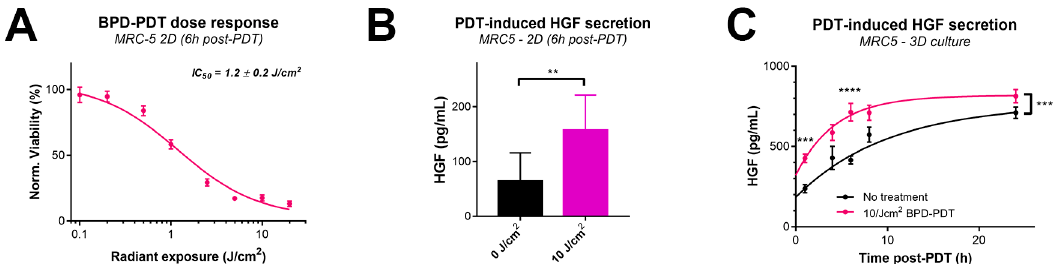
Figure 4. PDT elevates HGF secretion by MRC5 cells in 2D and 3D. ( A ) Efficacy of benzoporphyrin derivative (BPD)–PDT on MRC5 cells cultured in 2D. Depicted are mean ± SEM from N ≥ 12 obtained from four technical repeats. ( B ) Quantification of 10 J/cm 2 PDT-induced HGF secretion in culture medium by MRC5 cells in 2D (mean ± SD from N = 4–8 from three technical repeats). ( C ) Quantification of HGF secretion in culture media by MRC5 spheroids. Depicted are mean ± SEM from N = 4–23 obtained from four technical repeats. Data were fitted using a one-phase decay equation. Statistical significance is indicated as * p < 0.05, ** p < 0.01, *** p < 0.005, or **** p < 0.001.